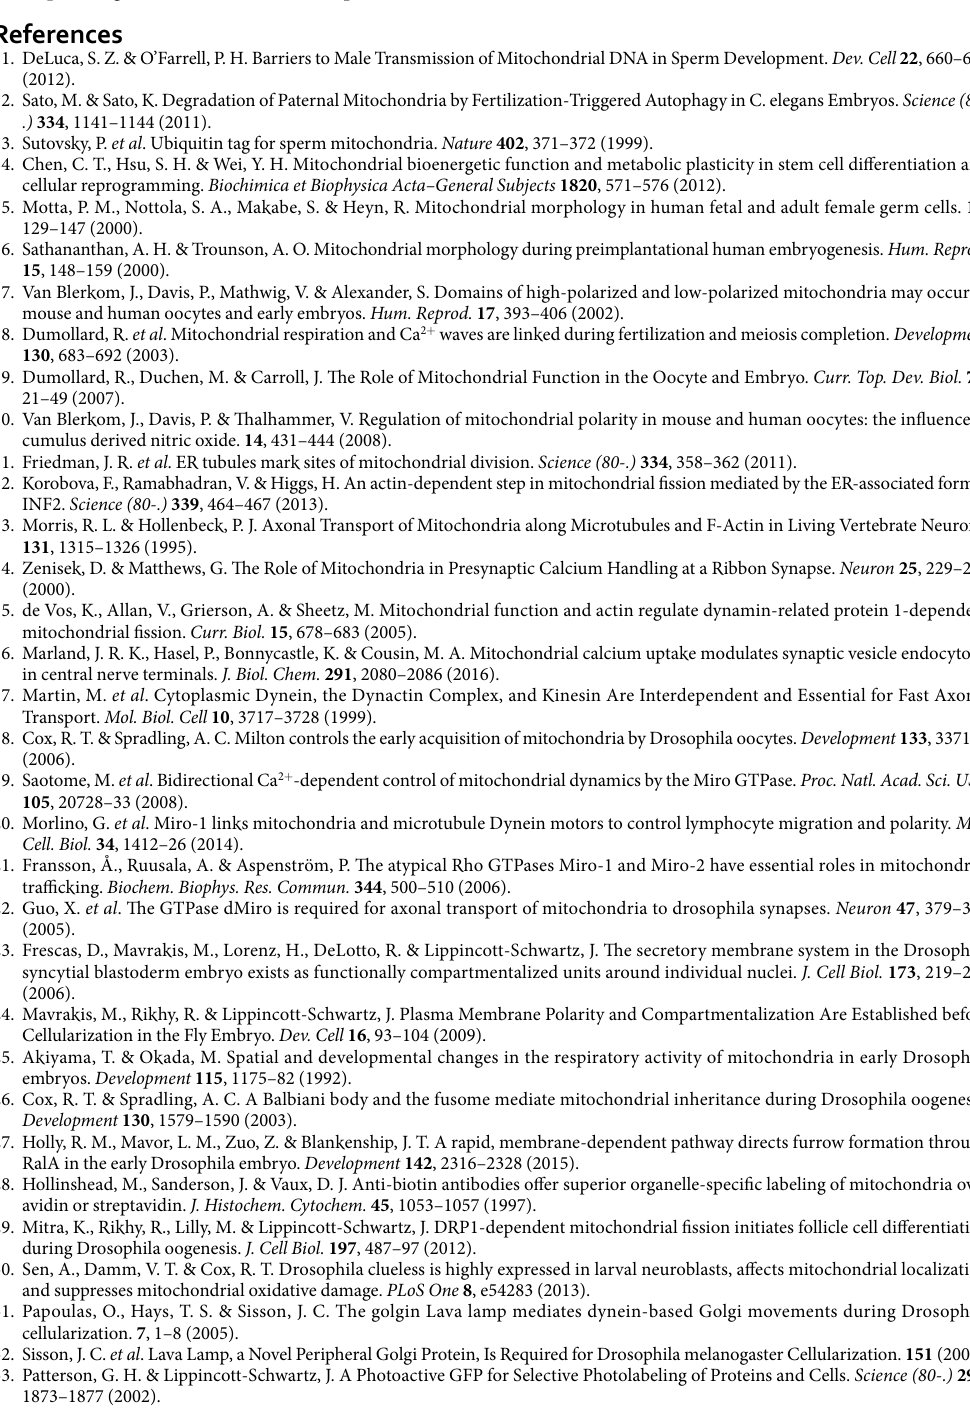
and the gain and the corresponding control was imaged at the exact same settings. Mean fluorescence intensity was measured across the whole optical plane and the minimum fluorescent intensity value was subtracted from each image. An average intensity was obtained from the respective control images and the treated/mutant/control fluorescence was normalized to this value to obtain a fold change in intensity across samples. Distributions were compared using two-tailed Mann- Whitney test on Graphpad prism 6.0 software. Metaphase furrow length. Lines were drawn along metaphase furrows in sagittal section images and lengths were measured in ImageJ for NC12 and 13. Mean furrow lengths were compared using two tailed Mann-Whitney test on Graphpad prism 6.0